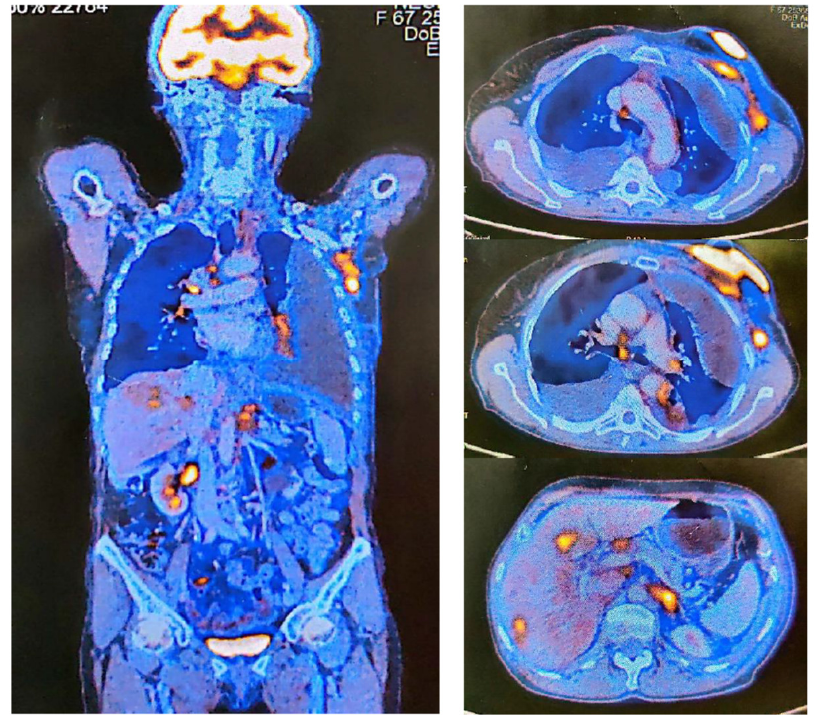
Figure 2. PET-CT from December 2020 with metabolically active lesions.